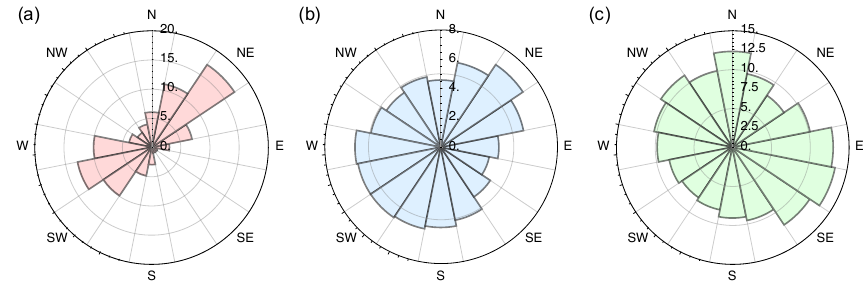
Figure 3. Wind regime at met mast station for 3-year period at 40ma.g.l.: (a) wind direction (%); (b) wind speed (ms − 1 ); (c) turbulence intensity